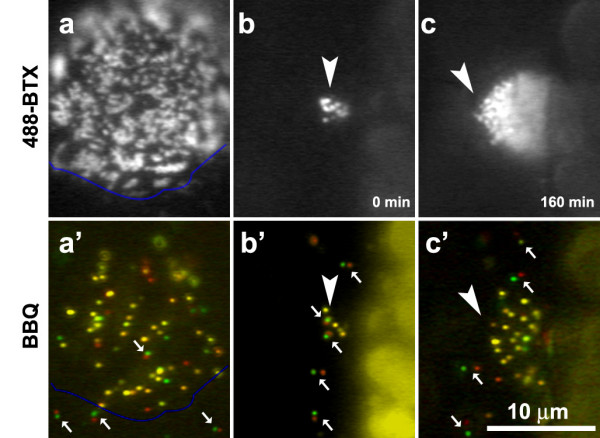
AChR movement within or near pre-patterned clusters. Consecutive time-lapse frames (separated by 2.5s) were pseudo-colored in red and green and superimposed. Yellow dots: immobile BBQs; paired green/red dots (arrows): mobile BBQs; un-paired green or red dots: BBQs that blinked during the recording and thus only one color was recorded. (a, a') A well-developed cluster on a 3-day old muscle cell shown by Alexa488-BTX (a) and BBQ (a') labeling with the blue lines outlining the lower edge of this hot spot. While most of the receptors within the cluster were immobile (yellow dots), those outside were mobile (small arrows). (b, b' and c, c') Development of an AChR cluster (arrowhead) in a 1-day old culture during a 3 hr recording period. b, c: Alexa488-BTX; b', c': BBQ.